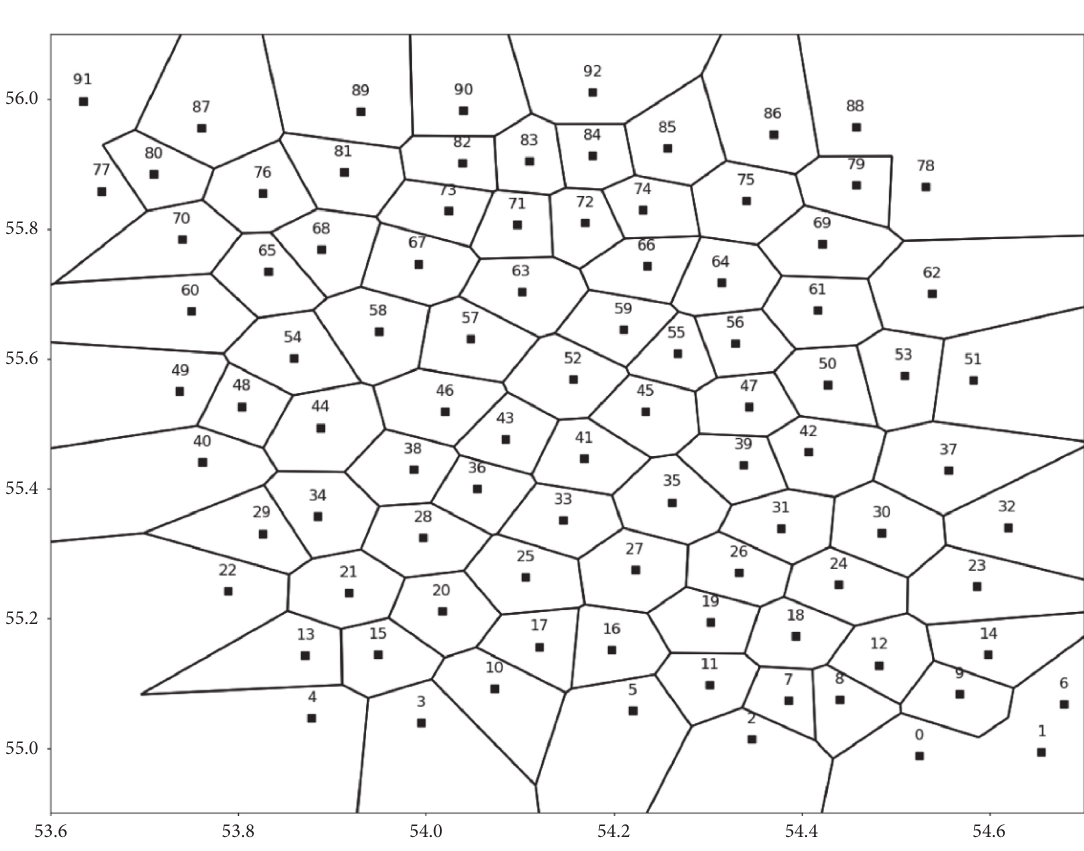
Figure 3: Dirichlet diagram.